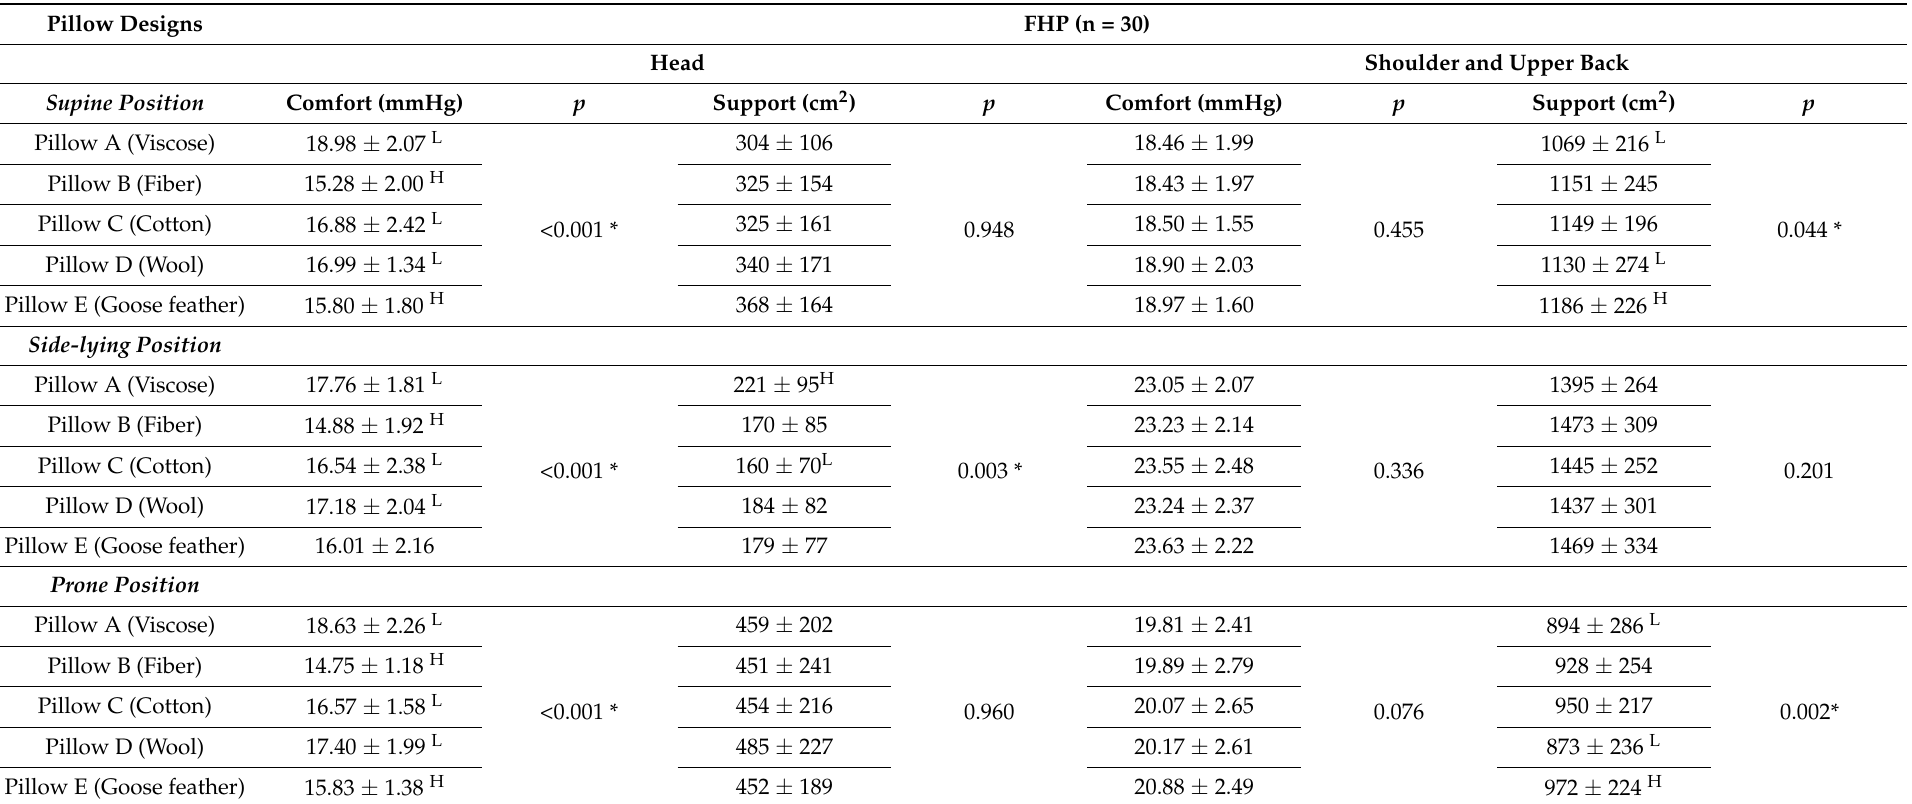
Table 4. Comparison of comfort and support values provided to individuals with FHP by different pillow